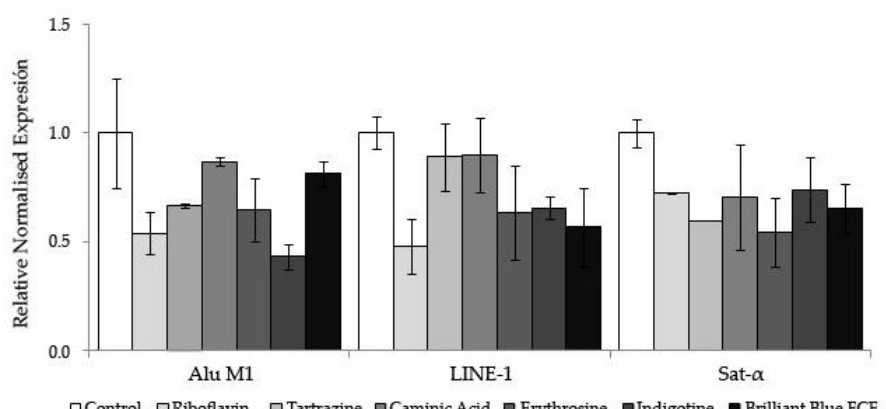
Figure 6. Methylation status of food colorings in HL-60 cells. Relative normalized expression data of each repetitive element (Alu M1, LINE-1, and Sat- α ). Values represent the mean ± SE from three independent experiments. Untreated cells grown in RPMI were used as a